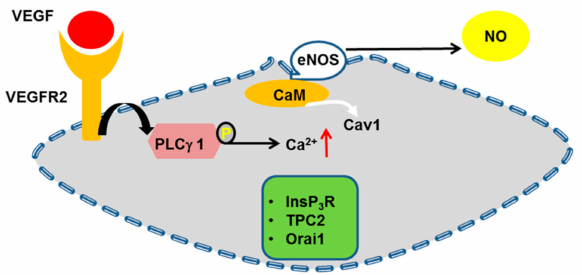
Figure 4. The Ca 2 + -dependent activation of the endothelial nitric oxide (NO) synthase (eNOS). VEGF binding to VEGFR2 causes an increase in intracellular Ca 2 + concentration that displaces caveolin 1 (CaV1) from eNOS, thereby removing the tonic inhibition and inducing NO release. VEGF may impinge on several Ca 2 + entry / release pathways to engage eNOS, including InsP 3 R, TPC2 and Orai1. See Figure 1 and Section 4.6. for further